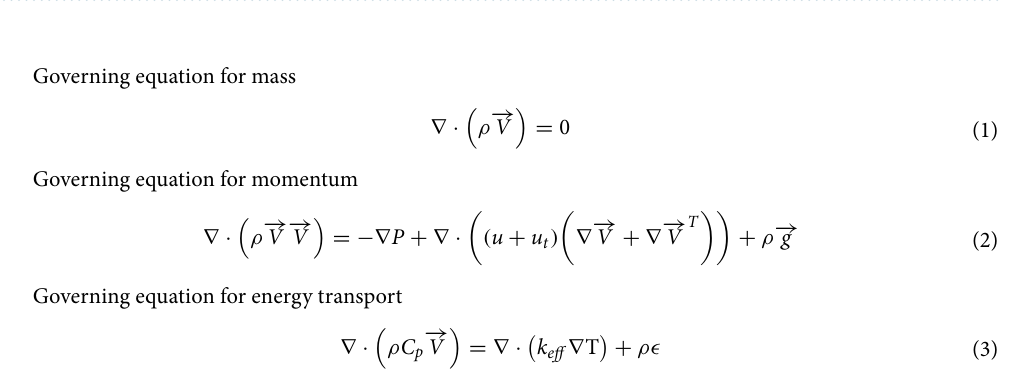
Table 1. Thermal-physical properties of DW, (SDBS-GNPs@DW) and (COOH-GNPs@DW) nanofluids 34 .